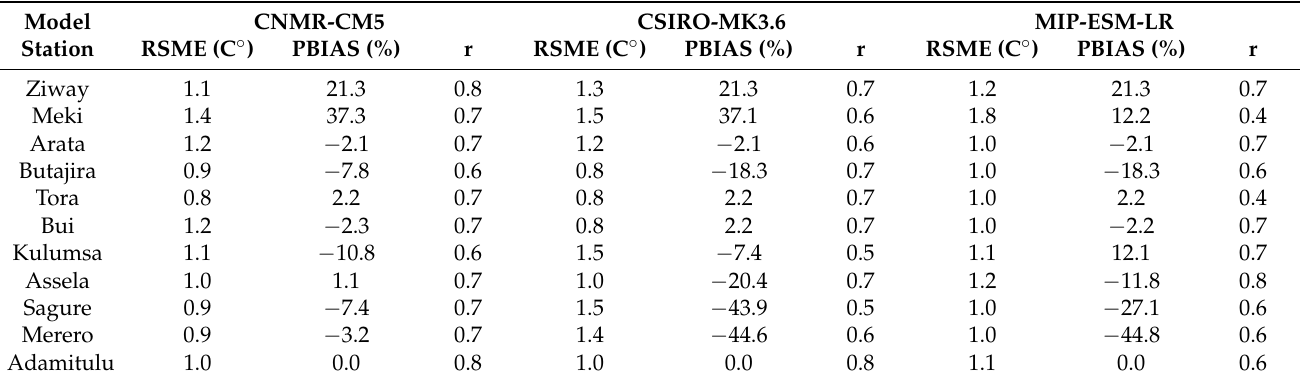
Table A4. Mann–Kendall trend and Sen’s slope estimator value for annual baseline and historical T max at Ziway Lake Basin from 1983 to 2005.